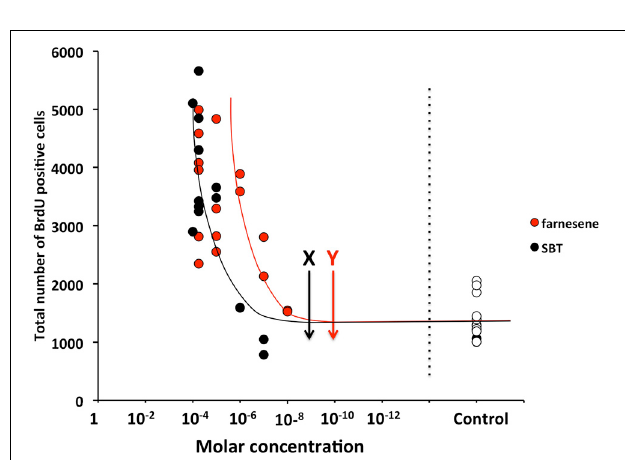
FIGURE 1 | Influence of exposure to soiled bedding and to synthetic analogs of mouse pheromones on the cell proliferation in the SVZ of female mice. BrdU + cells (green fluorescence) in the SVZ of females exposed to farnesene (A) or clean bedding (B) . LV: lateral ventricle. Dashed line indicates the border of lateral ventricle. Scale bar = 100 μ m. (C) Total number of BrdU labeled cells ( + SD) in the SVZ of female mouse. Female mice exposed to male-soiled bedding ( n = 7) showed higher cell proliferation